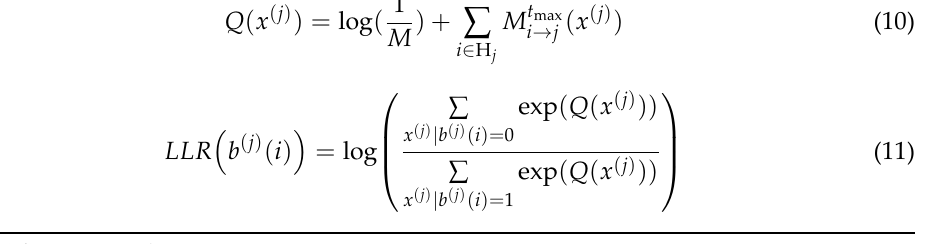
Algorithm 1. Asynchronous